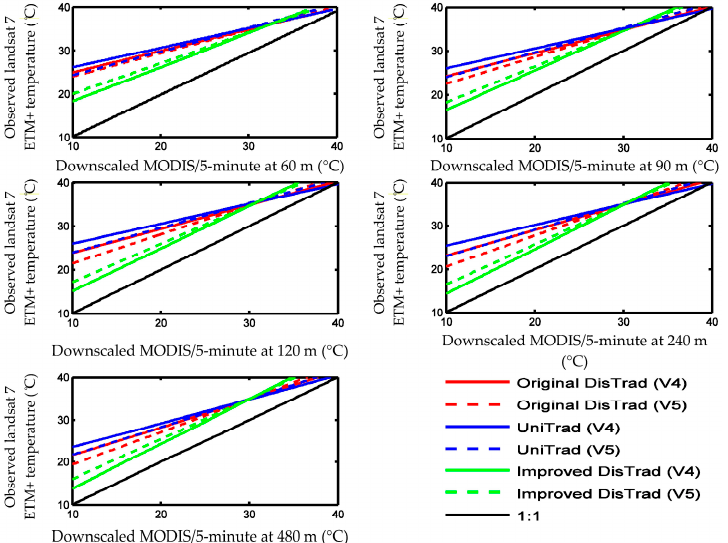
Figure 12. Linear regressions of the downscaled MODIS 5-Min land surface temperature products (V4 and V5) using the improved DisTrad, the original DisTrad, and UniTrad methods with the observed Landsat 7 ETM+ land surface temperature image at different resolutions (e.g., 60, 90, 120, 240, and 480 m). The dashed line represents V5 and the sold line represents V4.